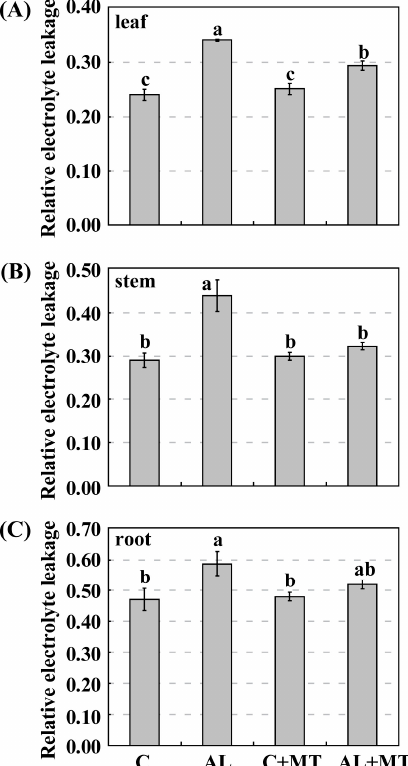
Figure 3. Effects of alkaline stress and melatonin treatment on relative electrolyte leakage (REL) in leaves ( A ), stems ( B ), and roots ( C ) from Malus hupehensis Rehd. seedlings. Lower-case letters indicate significant differences among treatments, based on Duncan’s multiple range test ( p < 0.05).